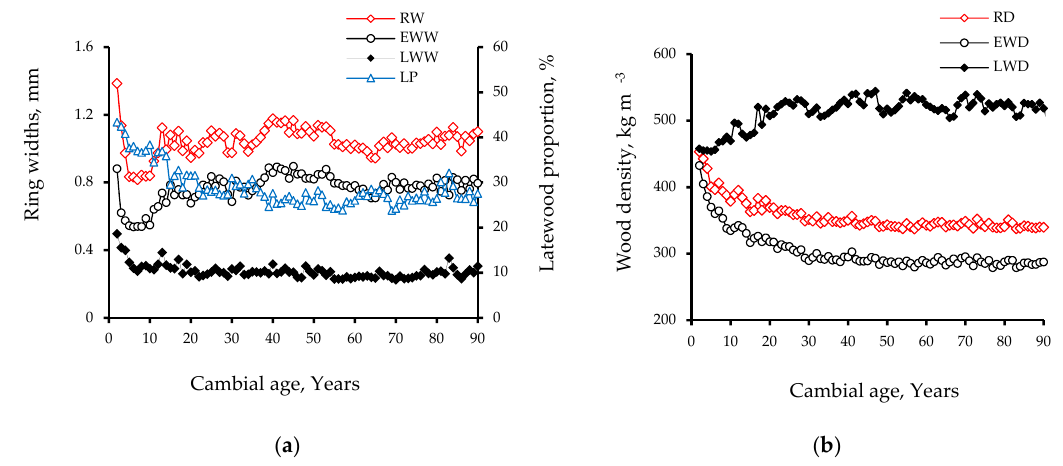
Figure 3. Radial variation patterns for: ( a ) annual ring width (RW, mm), earlywood width (EWW, mm), latewood width (LWW, mm) and latewood proportion (LP, mm) and ( b ) annual ring density (RD, kg m − 3 ), earlywood density (EWD, kg m − 3 ) and latewood density (LWD, kg m − 3 ) in 44 T. occidentalis trees.